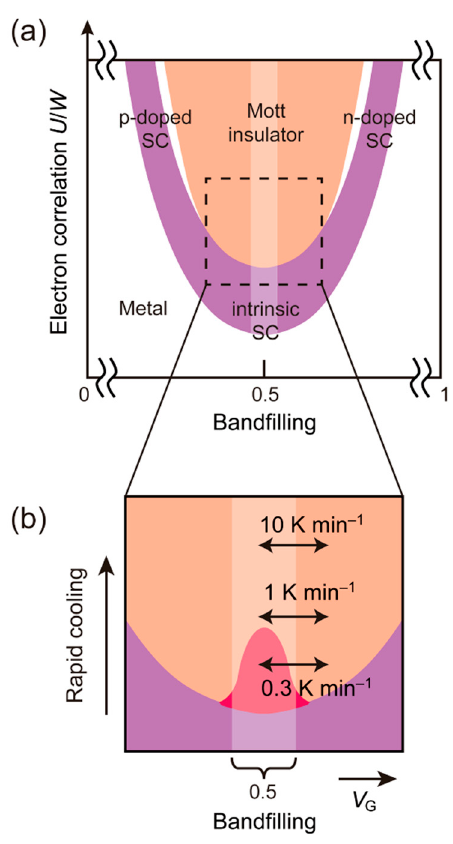
Figure 3. ( a ) Schematic phase diagram of κ -BEDT-TTF salts around Mott insulator against electron correlation and band-filling at fixed temperature well below T C [10,15]. Half-filled state is